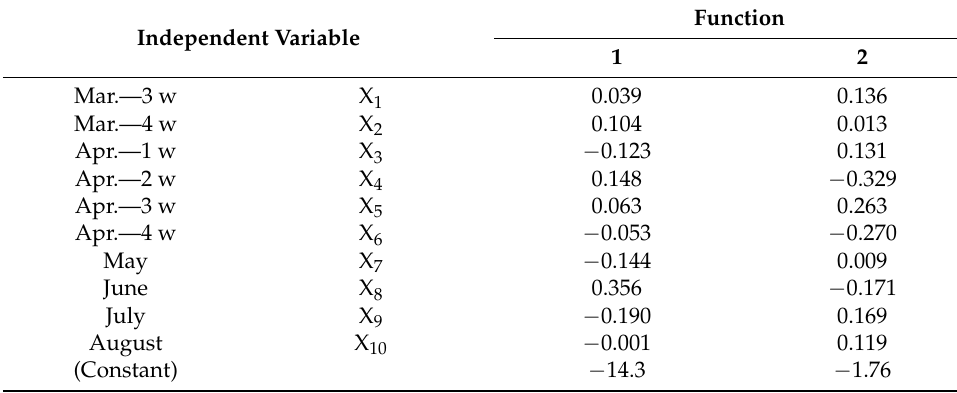
Table 7. Canonical discriminant function